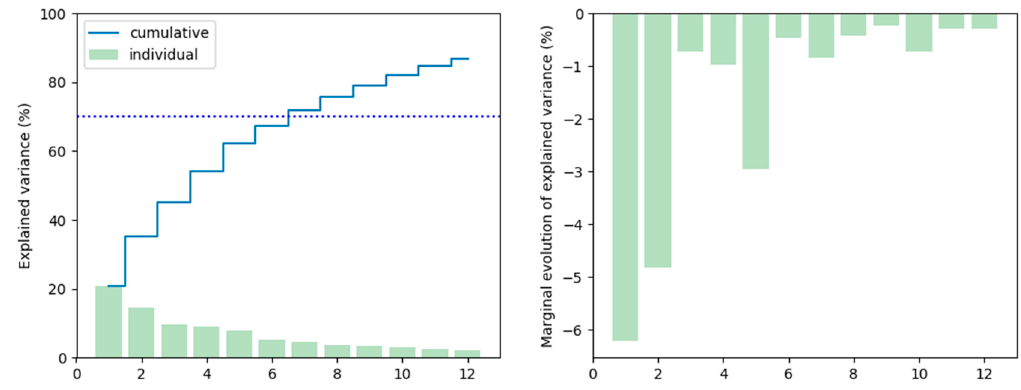
Figure 3. Explained variance for choosing the number of principal components.